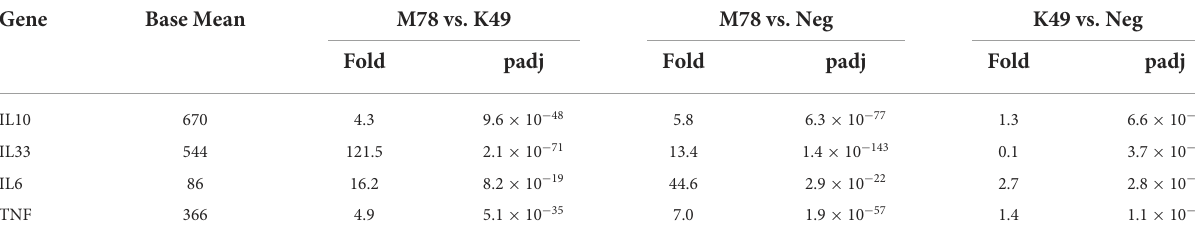
TABLE 5 Differential expression of cytokine genes in PBMCs infected with ASFV strains K49 or M78 (FDR ≤ 0.05). Gene Base Mean M78 vs. K49 M78 vs. Neg K49 vs. Neg Fold padj